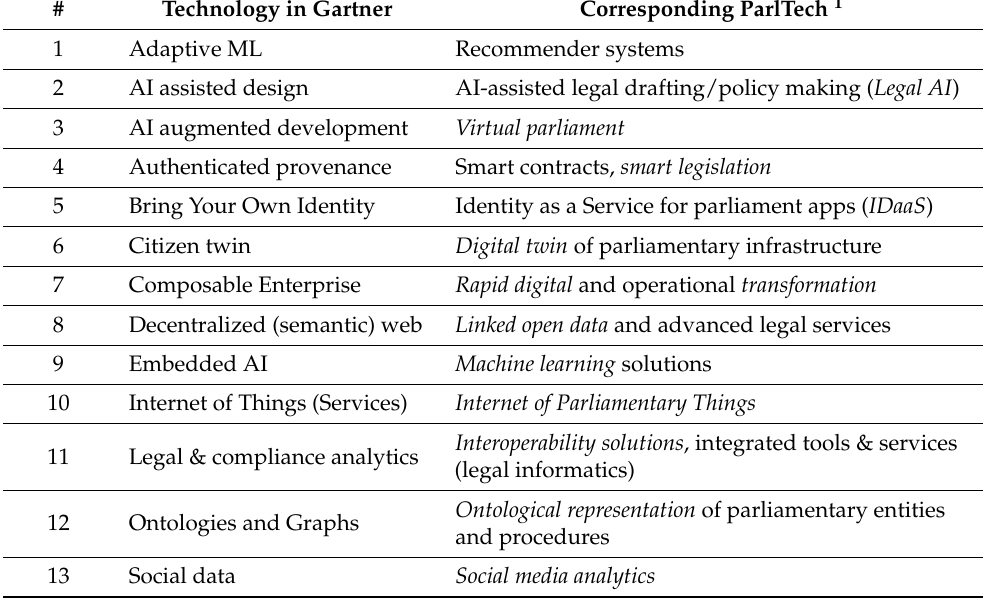
Table 1. Technologies for the parliamentary